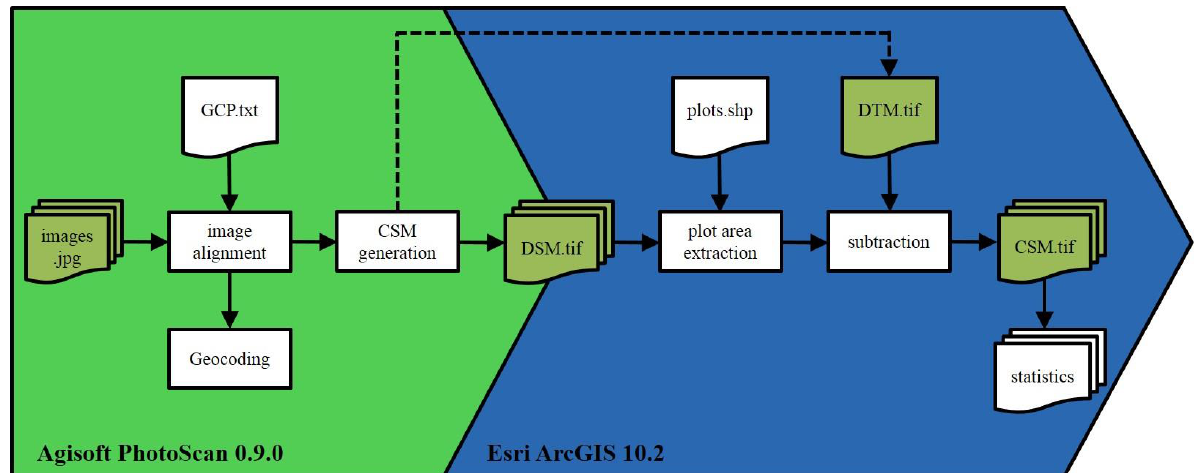
Figure 3: Data processing workflow for CSM